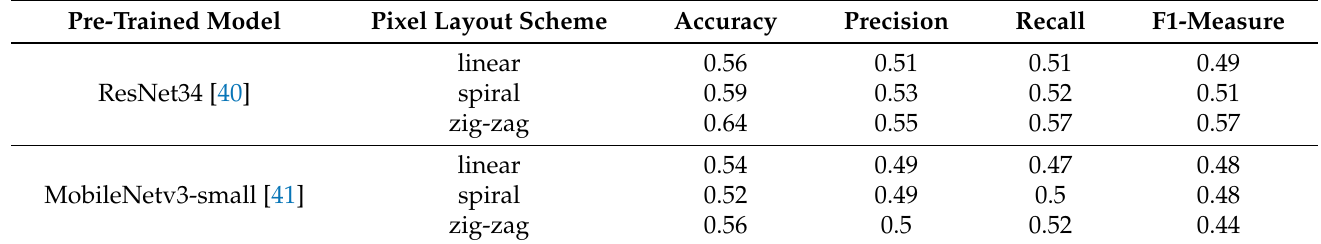
Table 3. Experimental results with pre-trained models and different pixel layout schemes. Pre-Trained Model Pixel Layout